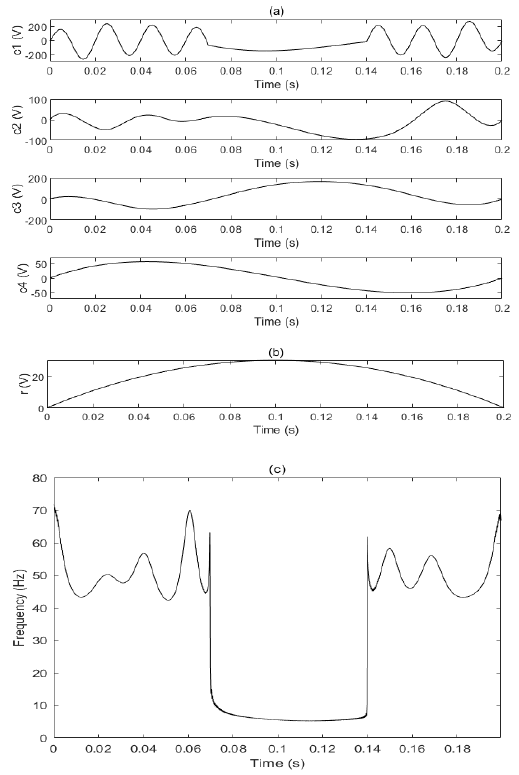
Figure 4. Voltage sag IMF components ( a ), margin ( b ), and frequency parameter ( c ).